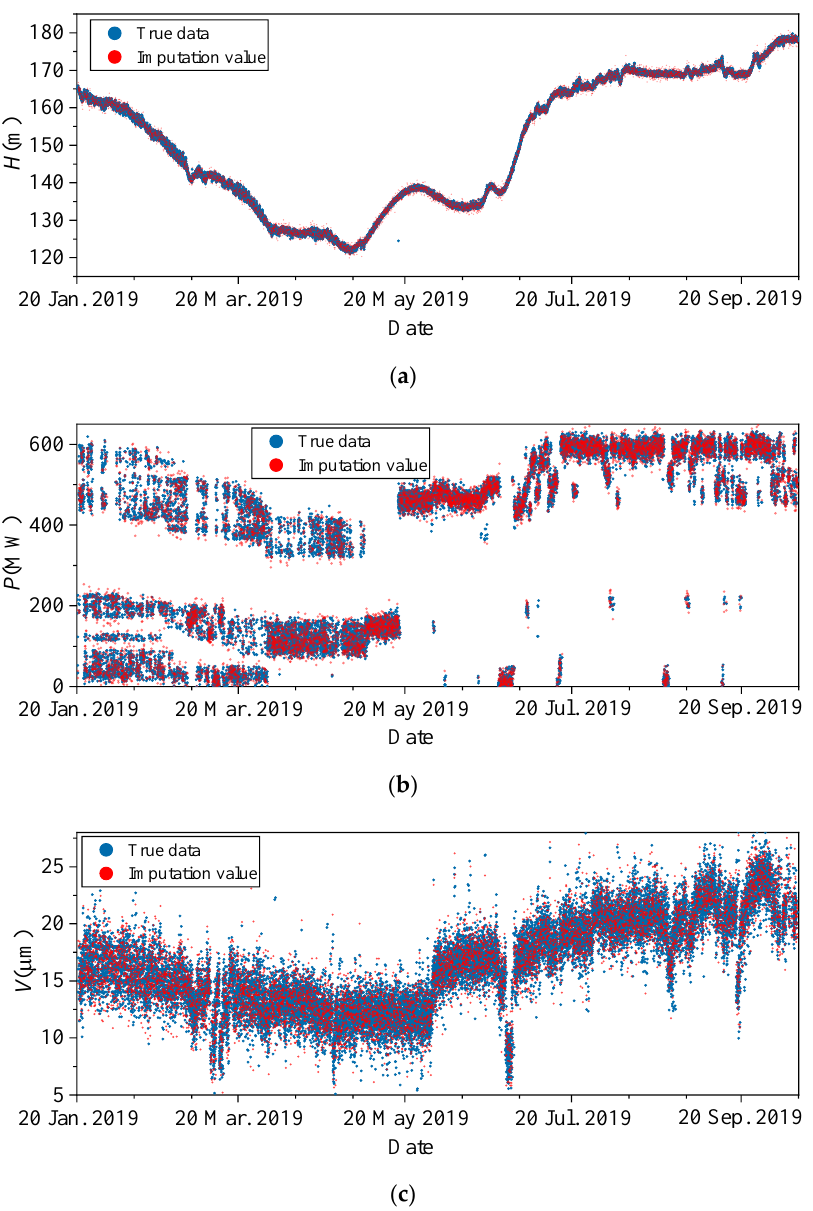
Figure 11. The results of data imputation: ( a ) water head H ; ( b ) active power P ; and ( c ) vibration amplitude of the top cover V .